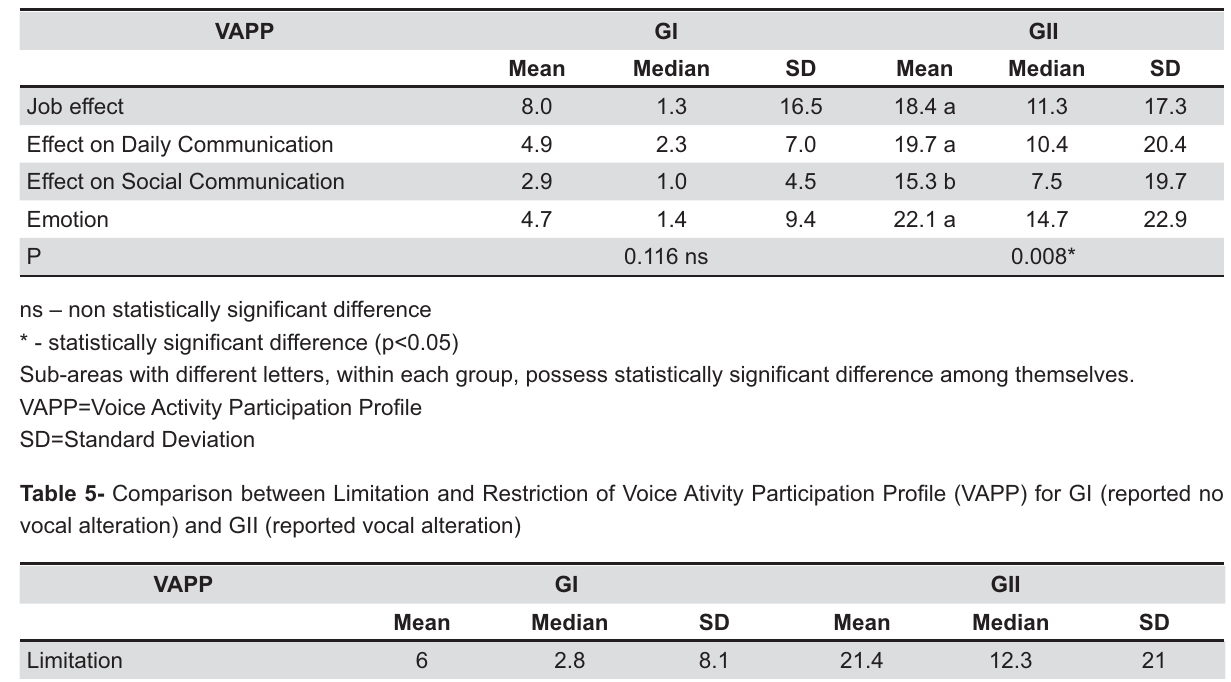
Table 4- (cid:10)/(cid:6)’(cid:16)(cid:14)(cid:15)(cid:7)(cid:21)(cid:6)(cid:17)(cid:10)(cid:14)’(cid:6)(cid:17)(cid:22)(cid:10)(cid:11)%(cid:9)(cid:10)(cid:21)!"#(cid:14)(cid:15)(cid:9)(cid:14)(cid:21)(cid:10)(cid:6)(cid:24)(cid:10)(cid:2)(cid:6)(cid:7)(cid:8)(cid:9)(cid:10)(cid:3)(cid:11)(cid:7)(cid:12)(cid:7)(cid:11)(cid:13)(cid:10)(cid:4)(cid:14)(cid:15)(cid:11)(cid:7)(cid:8)(cid:7)(cid:16)(cid:14)(cid:11)(cid:7)(cid:6)(cid:17)(cid:10)(cid:4)(cid:15)(cid:6)(cid:18)(cid:19)(cid:9)(cid:10)(cid:25)(cid:2)(cid:3)(cid:4)(cid:4)(cid:30)(cid:10)(cid:24)(cid:6)(cid:15)(cid:10);>(cid:10)(cid:25)(cid:15)(cid:9)(cid:16)(cid:6)(cid:15)(cid:11)(cid:9)(cid:23)(cid:10)(cid:17)(cid:6)(cid:10)(cid:12)(cid:6)(cid:8)(cid:14)(cid:19)(cid:10)(cid:14)(cid:19)(cid:11)(cid:9)(cid:15)(cid:14)(cid:11)(cid:7)(cid:6)(cid:17)(cid:30)(cid:10) and GII (reported vocal alteration)